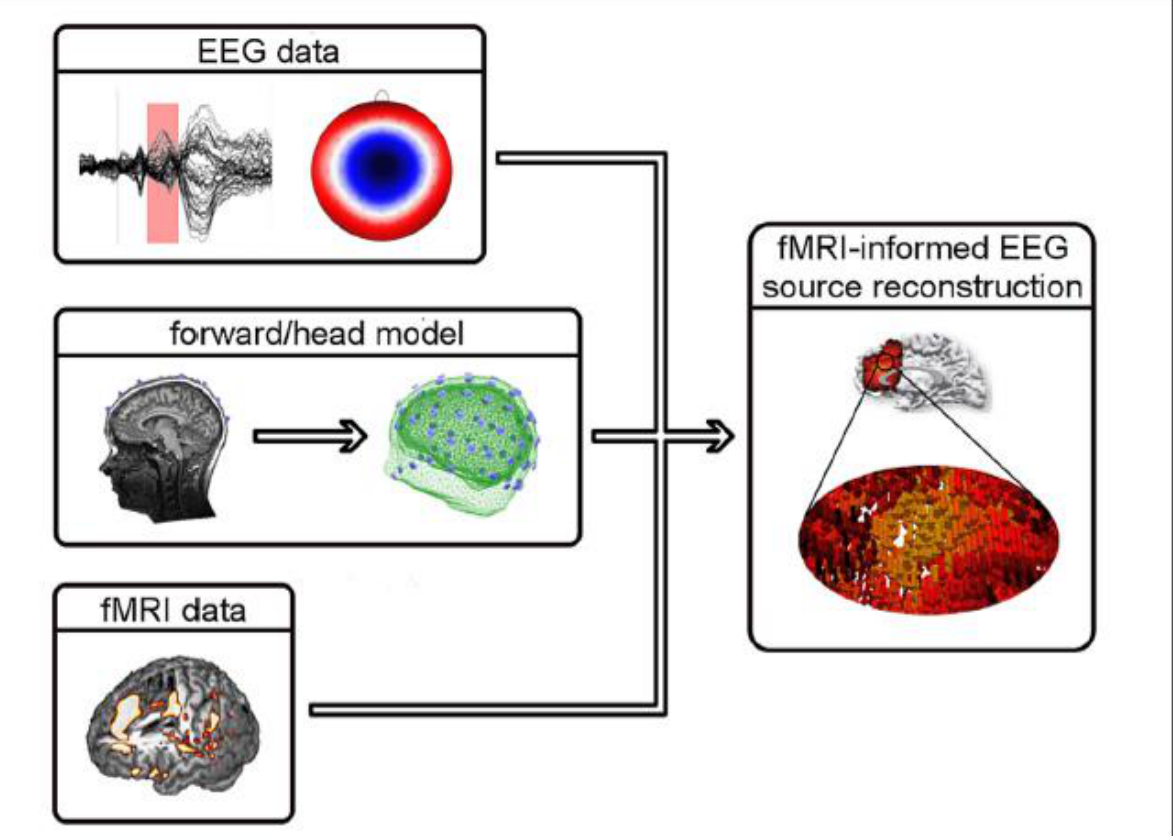
Figure 3. Illustration of fMRI-informed EEG source reconstruction. To estimate the location and activity of active cortical patches in the brain that lead to measurable EEG signal changes on the scalp, forward or head models are constructed from individual MR images. Here, volumes representing skin, skull, and brain tissue have been extracted. Based on such a model and the EEG time courses as well as corresponding scalp topographies (the pattern of EEG activity as recorded on a participant’s head), the EEG sources can be inferred (inverse modelling). Statistical maps from a standard fMRI analysis are used to further constrain the possible source constellations. The procedure used here for inverse modelling computes a high number of dipolar sources distributed across the brain, each of which is characterized by its position, orientation (pointing direction of an arrow), and strength (as indicated by colouring). Reproduced under open access license agreement CC BY-NC-SA 3.0 from Ref. [70]. Copyright 2012 the